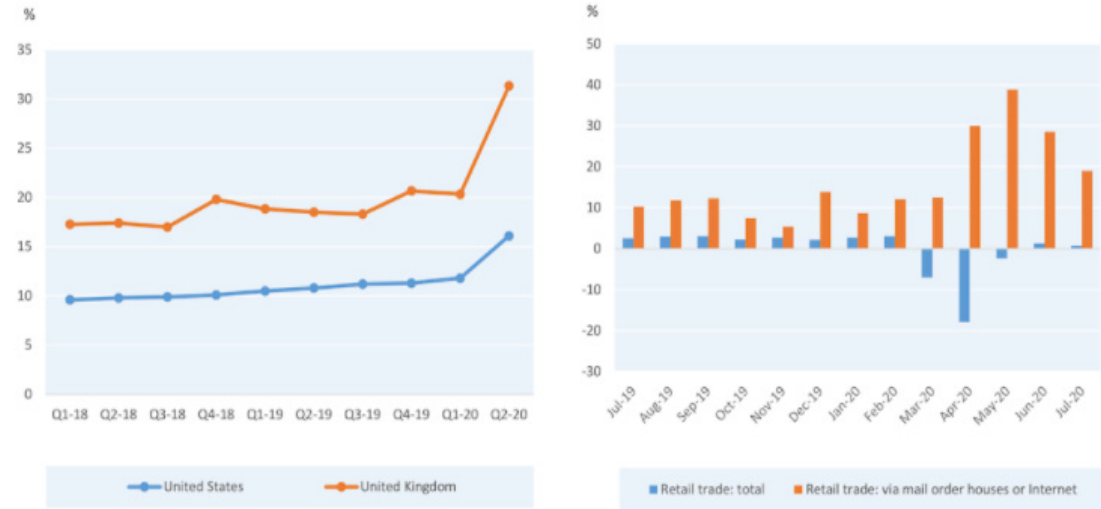
Figure 1. Share of e-commerce in total retail sales, U.K. and U.S. (20182020). Source: E-commerce in